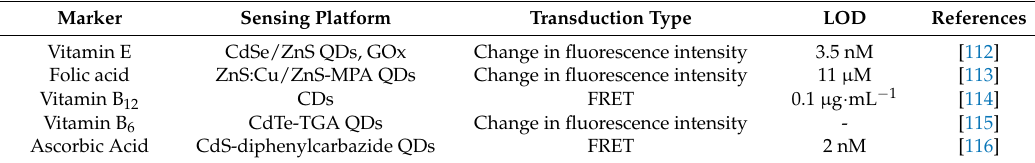
Table 10. QDs-based sensors for vitamins determination.